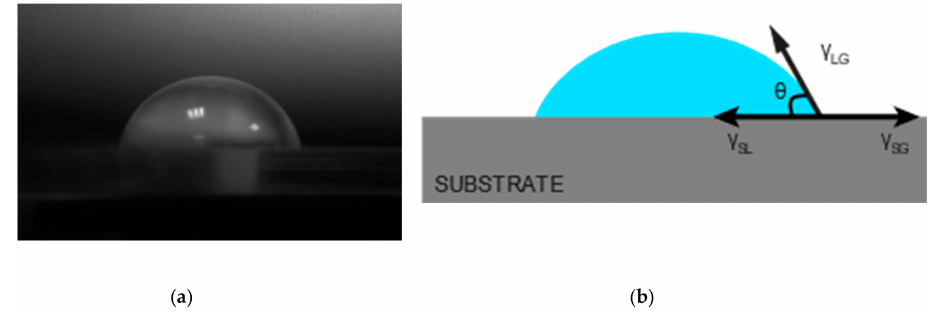
Figure 2. ( a ) Picture of a sessile drop in equilibrium on a polymer substrate. ( b ) Representation of the interfacial forces acting on a droplet on a substrate. The contact angle, θ , is less than 90 ◦ , indicating a partial wetting of the